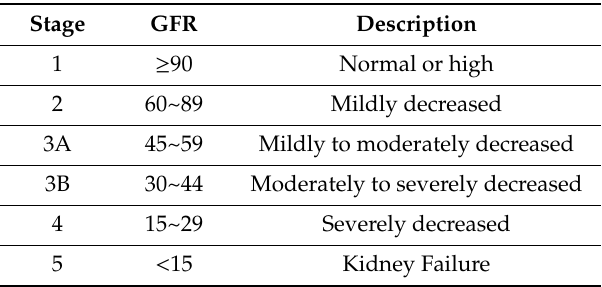
Table 2. Stages of glomerular filtration rate (GFR). Stage GFR